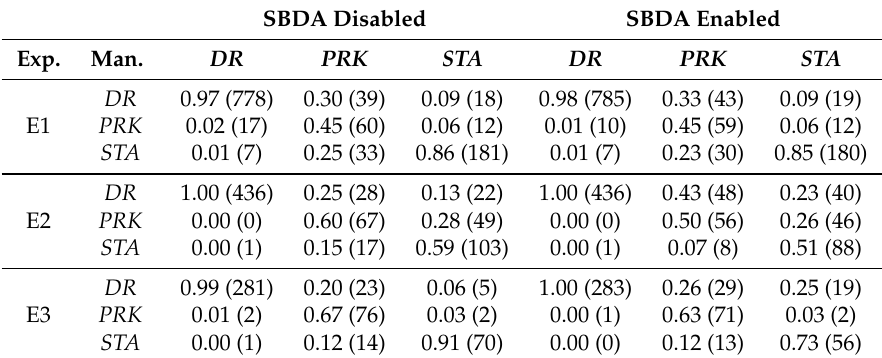
Table 14. System’s confusion matrix for the experiments in terms of percentage and number of instances (in brackets). SBDA, speed-based breakout detector